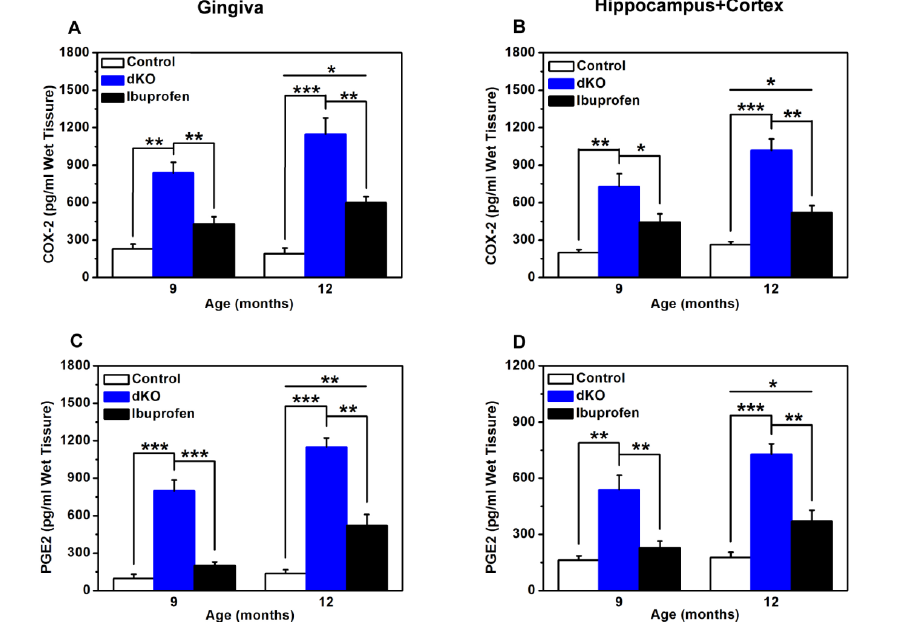
Figure 5. ELISA measurements of COX-2 ( A , B ) and PGE2 ( C , D ) in control, naive dKO, and ibuprofen-treated dKO mice at nine and 12 months. ( A , C ) Gingiva of the incisor